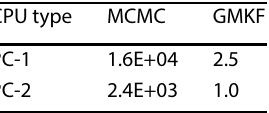
Table 1 CPU time (s) for GMKF (SQRT updates) versus MCMC computations on two different processors; ∗ PC-1—